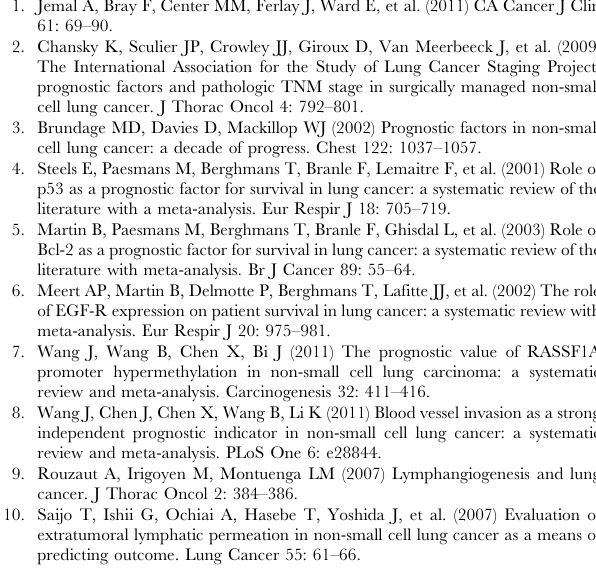
Figure S1 The flow of the included studies. Table S1 Characteristics of literatures excluded in this systematic review. Table S2 Data source for the estimating of HR form included studies evaluating lymphatic vessel invasion and outcome. Table S3 Other clinicopathological variables in multi- variate analysis of LVI and OS. Table S4 Main characteristics and results of eligible studies evaluating LVI and RFS or OS in patients with